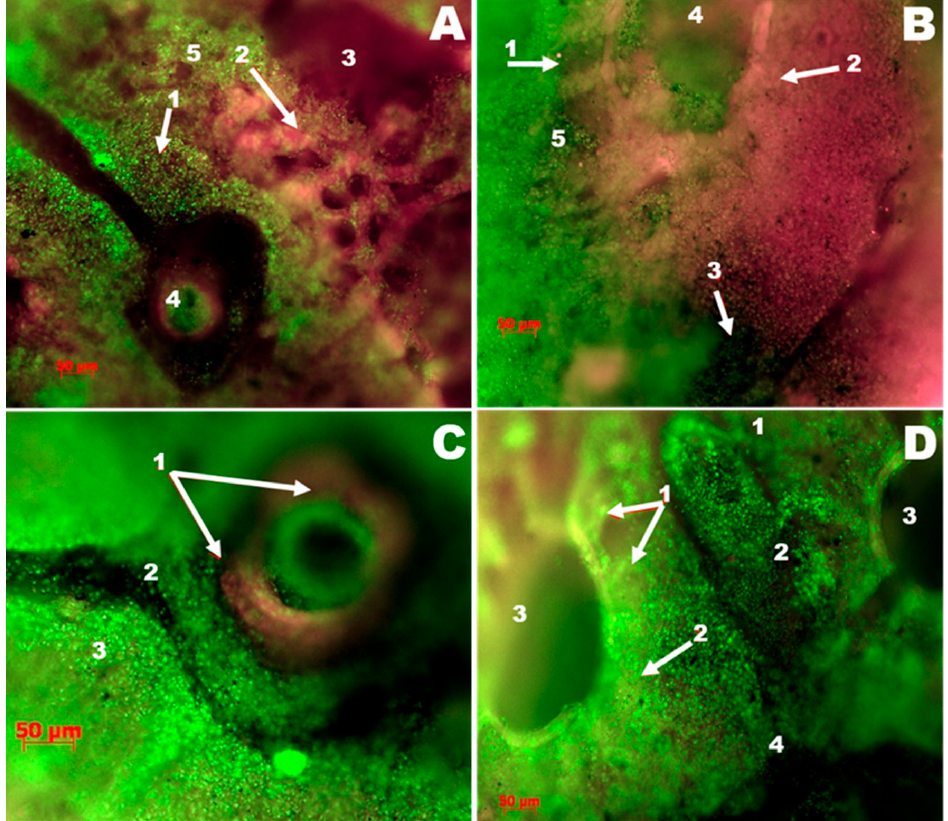
Figure 2. Luminescence microscopy photograph. Lungs and parabronchi of the control group stained with SYBR Green and Sypro Ruby (x50). A . Interstitial inflammation in the lungs: 1—infil ‐ with SYBR Green and Sypro Ruby ( × 50). ( A ) Interstitial inflammation in the lungs: